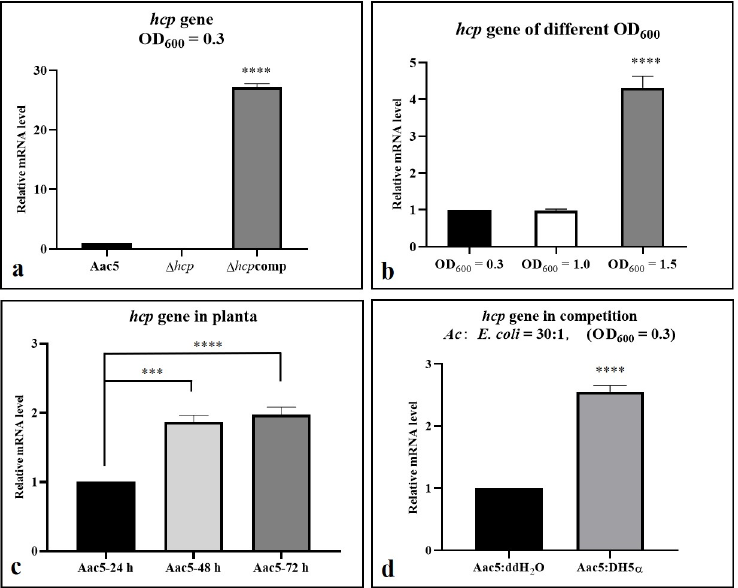
Figure 7. Activation of Acidovorax citrulli hcp as determined by hcp relative expression level. qRT- PCR assays were performed to determine the relative hcp mRNA levels under different growth con- ditions. ( a ) Relative expression of hcp in Aac5, ∆ hcp , and ∆ hcp comp under inactivated conditions (OD 600 = 0.3). ( b ) Relative expression of hcp in WT strain Aac5 at different cell concentrations (OD 600 = 0.3, 1.0, and 1.5). ( c ) Relative expression of hcp in Aac5 at 24, 48, and 72 h post inoculation (hpi) of watermelon cotyledons (10 4 CFU·mL − 1 ). ( d ) Relative expression of hcp in Aac5 and ∆ hcp comp